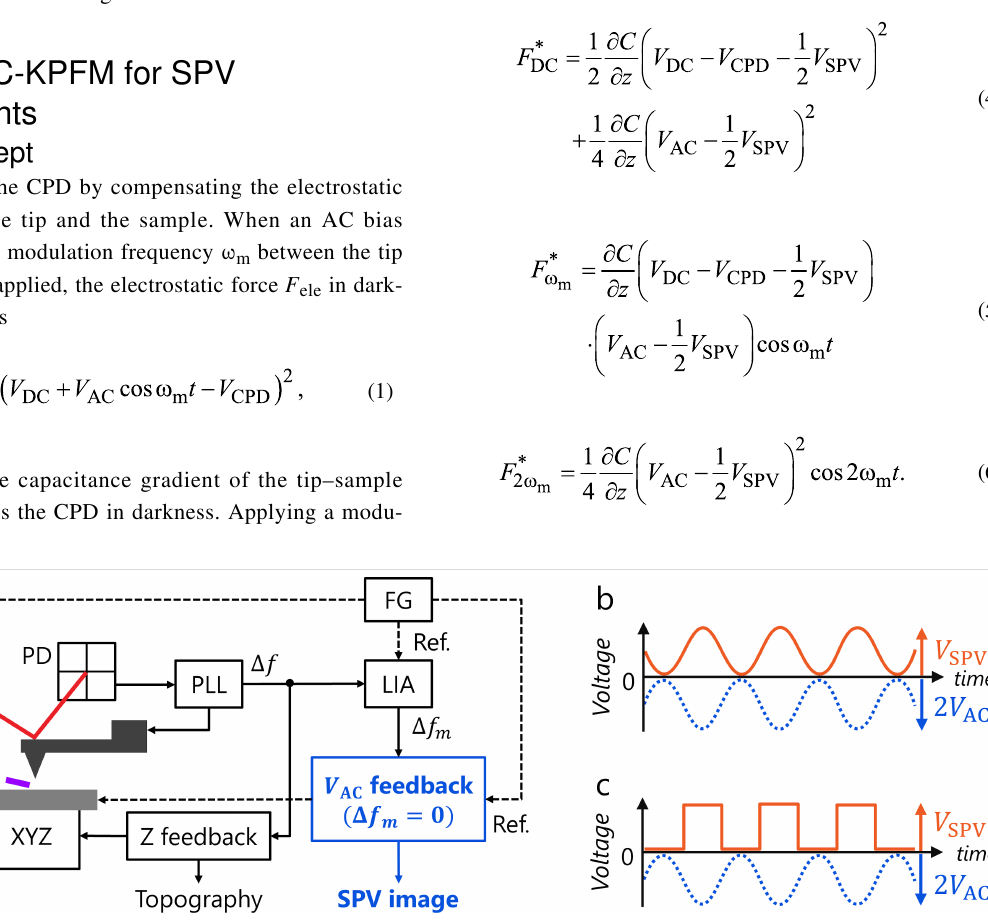
Figure 1: Schematics of AC-KPFM for direct SPV measurements. (a) Block diagram of AC-KPFM in FM mode. FG is a function generator. (b, c) Scheme of the AC bias nullifying method by laser power modulation with (b) sinusoidal and (c) square waveforms, which are synchronized to V AC